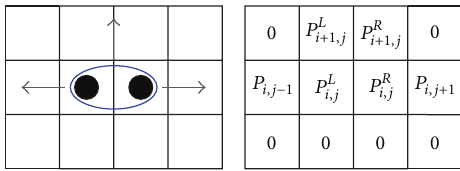
Figure 5: Moving directions and transition probabilities of P - pedestrians.